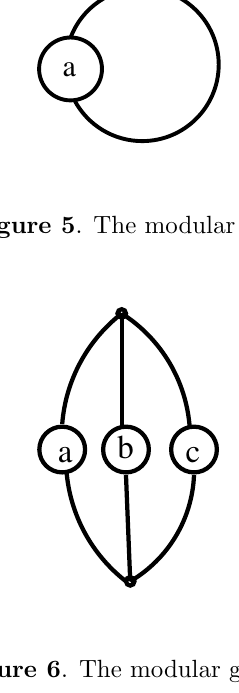
Figure 6 . The modular graph C a;b;c